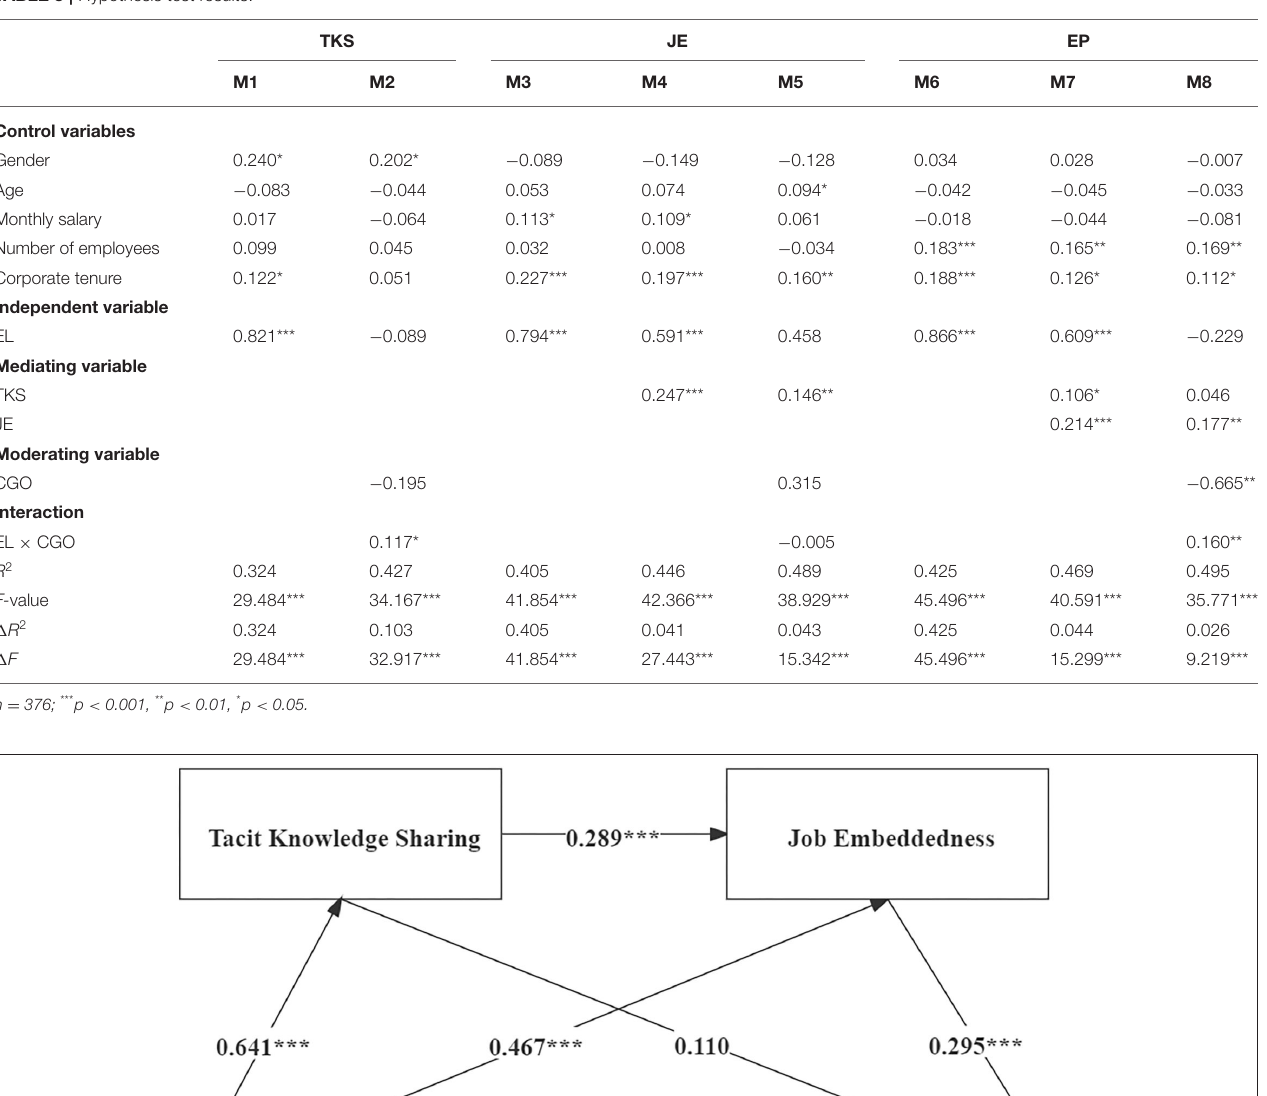
3, and hypothesis 4 were confirmed. Furthermore, Table 5 shows that the mediating association of TKS and the serial mediating association of TKS and JE were strengthened with the elevation of CGO. Therefore, hypothesis 6 and hypothesis 7 are